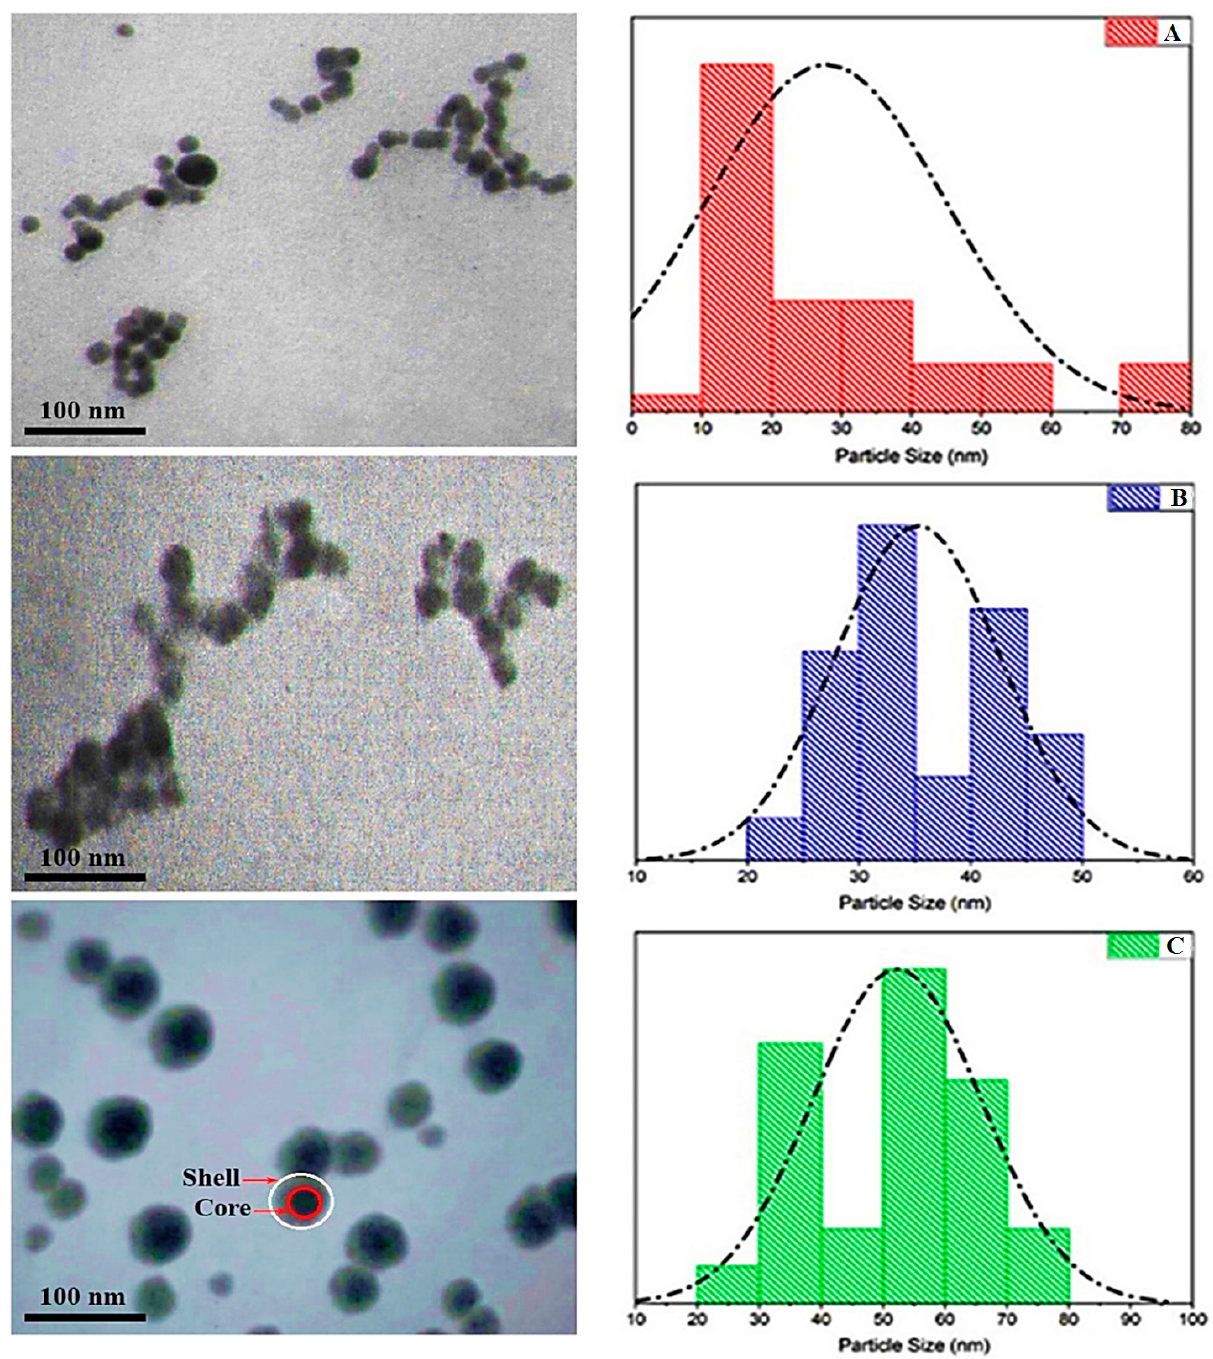
Figure 1. TEM images with particle size distribution histograms of Au NPs, ZnO NPs, and Au/ZnO NCs, where ( A ) is Au NPs, ( B ) is ZnO NPs, and ( C ) is Au/ZnO NCs, prepared via laser ablation at 800 mJ. Core referred to Au and shell referred to ZnO.